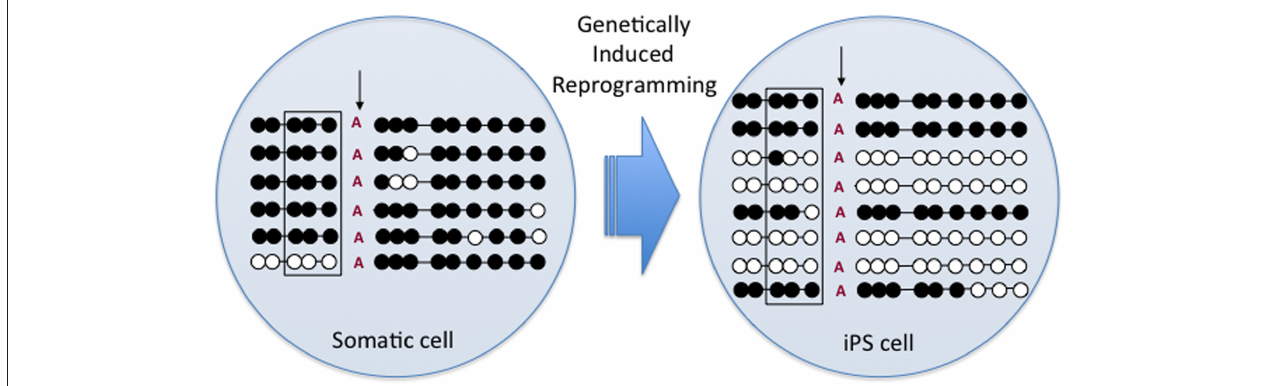
paternal allele DMR as confirmed by a Bos indicus -specific SNP (vertical arrow). Square indicates location of the CTCF binding site also indicating significant de-methylation after iPS cell